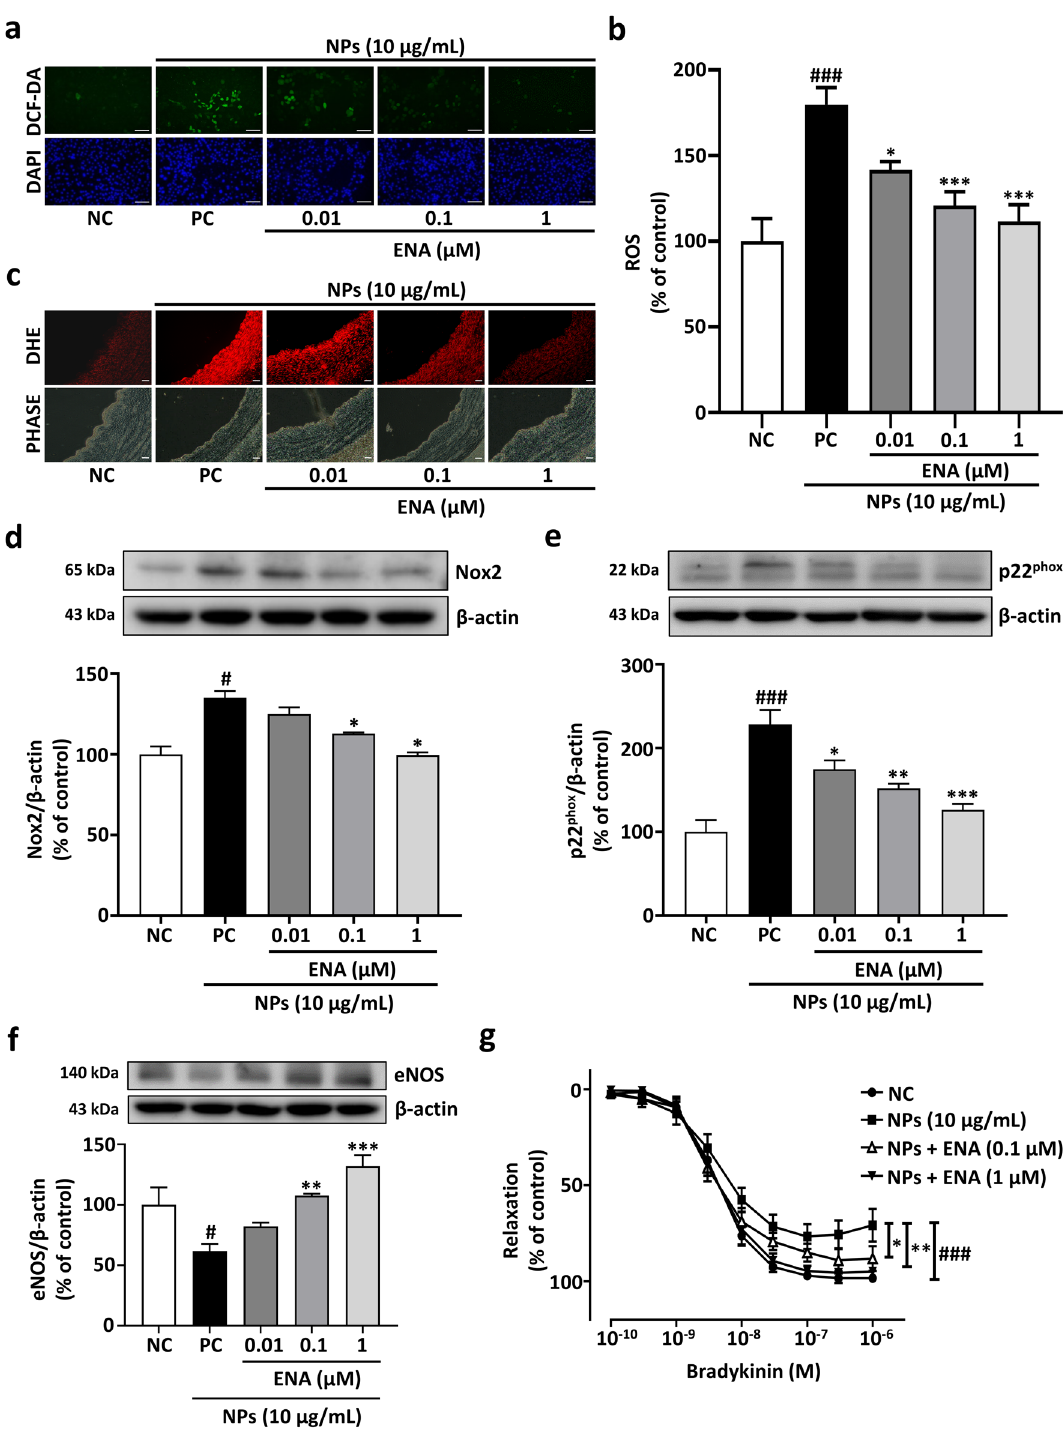
Figure 5. SGLT2 inhibition reduces NPs induced oxidative stress and prevents endothelial dysfunction. ( a ) Representative fluorescence microscopy images of DCF ‐ DA in live adherent ECs with corresponding 4 ′ ,6-Diamidino-2-phenylindole (DAPI) staining after the 24 h treatment of NPs (10 μg/mL) alone or with ENA (0.01, 0.1, 1 μM); scale bar = 500 μM. ( b ) Quantification of relative DCF-DA fluorescence intensity measured as a percentage of control. Data are the mean ± SEM (n = 5–6). * p < 0.05; *** p < 0.001 versus PC (complete media + NPs 10 μg/mL); ### p < 0.001 versus NC (complete media). ( c ) Representative microscopy images of ethidium fluorescence in arterial rings; scale bar = 100 μM. ( d-f ) Representative immunoblots of Nox2, p22 phox (upper band) and eNOS proteins with their corresponding cumulative data. Data are the mean ± SEM (n = 3). * p < 0.05; ** p < 0.01; *** p < 0.001 versus PC; # p < 0.05; ### p < 0.001 vs. NC. ( g ) Concentration-relaxation curve in response to BK after 24 h treatment with NPs (10 μg/mL) alone or with ENA (0.1 and 1 μM). Data are the mean ± SEM (n = 7–13). * p < 0.05; ** p < 0.01 versus PC; ### p < 0.001 versus